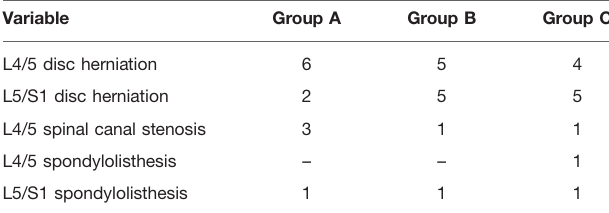
TABLE 2 | Clinical radiographic data of three groups that underwent